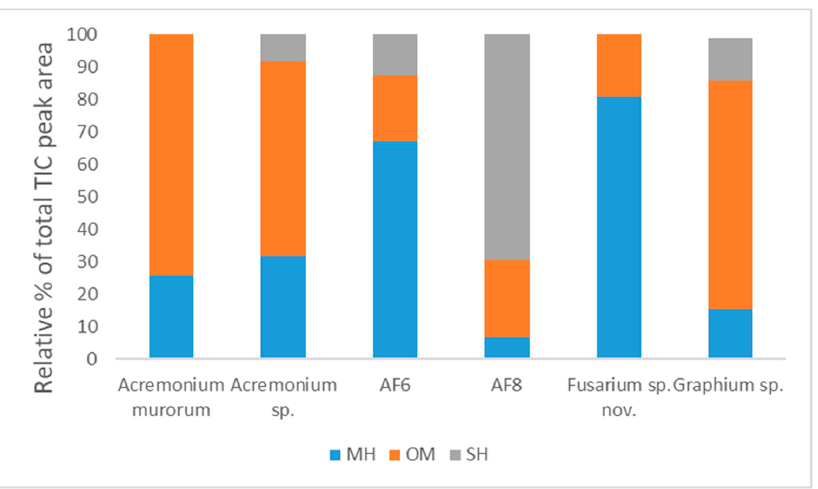
Figure 2. Percent composition of terpenoid classes in the fungal symbionts of E. perbrevis . MH—monoterpene hydrocarbons; OM—oxygenated monoterpenes; SH—sesquiterpene hydrocarbons. The results of principal component analysis (PCA) are indicated by the principal components (PC) score and loading plots (PCA-Biplot). The PCA of volatile components yielded three PCs with eigenvalues ≥ 1, accounting for 97.01% of the total variance across the entire dataset. The first, second, and third PCs contributed 49.41%, 31.30%, and 16.30% of the total variance, respectively (Table 2). Scores and loading plots of the first two PCs obtained from volatile emissions of six symbionts are presented in Figure 3. The PCA showed three different groupings: A. murorum and Graphium sp. are located separately in the upper and lower right quadrants, respectively, while Acremonium sp ., AF-6, AF-8 and Fusarium sp. nov. are clustered in the lower left quadrant. Figure 3 displays the variables factor map indicating the discriminating emissions among the symbionts. Compounds 6 ( cis - p -menth-2-en-1-ol), 9 (terpinen-4-ol), 10 ( α -terpineol), 11 ( trans -piperitol), 12 ( β -